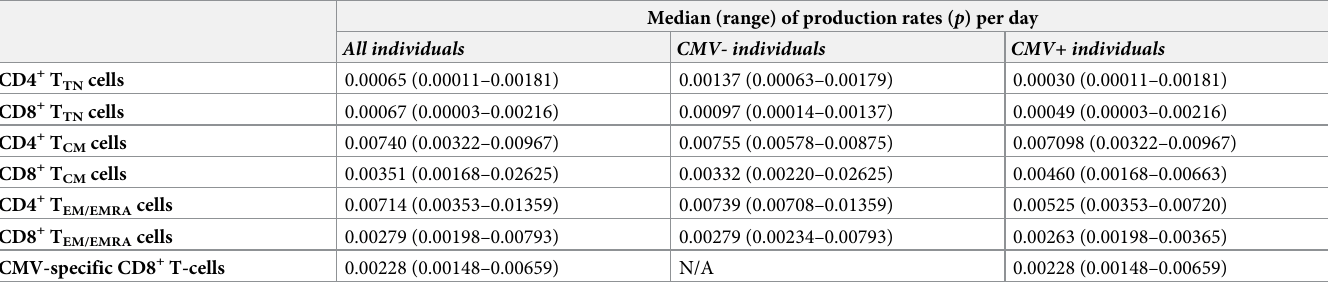
Table 2. Median (range) of production rates ( p ) of the different T-cell subsets.